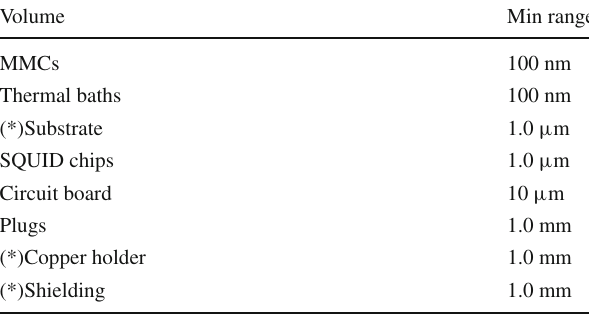
Table 1 Minimum distanced produced particles have to travel in the material. If the particles have less energy, they are not produced and their energies are deposited locally. Volumes marked with (*) contain subvolumes with different production thresholds (see Fig. 4)